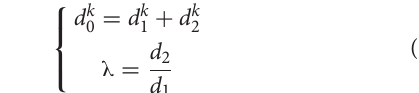
FIGURE 3 | The schematic of the hemodynamic parameters at a bifurcation.